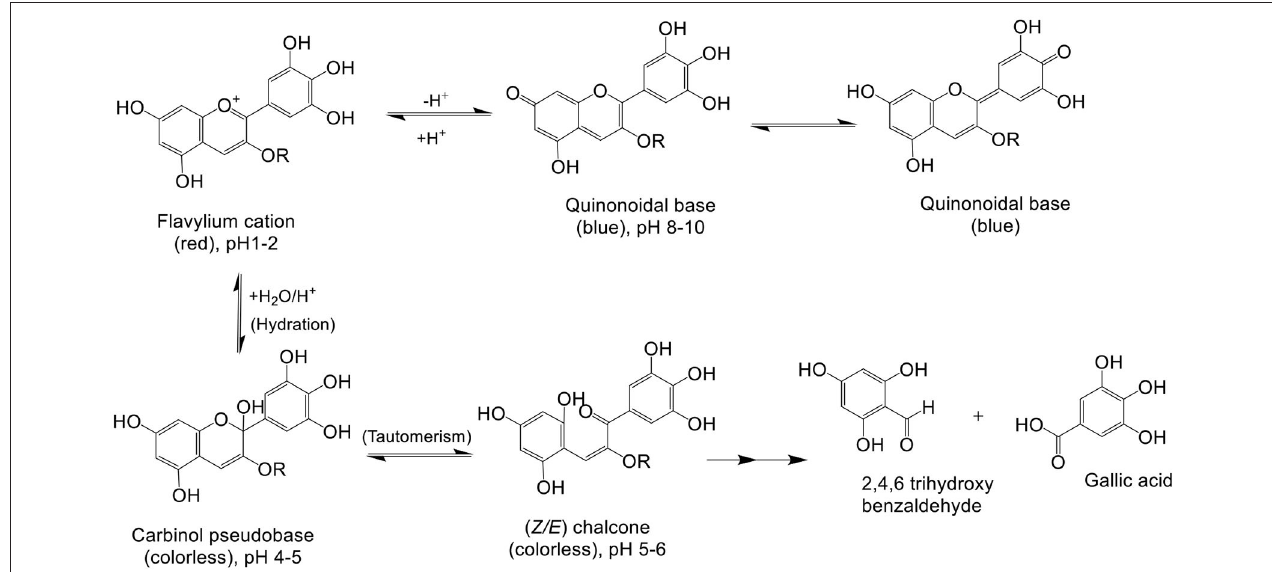
FIGURE 4 | pH-mediated degradation of delphinidin: in low pH, 1–2 red colored flavylium cations are observed, in alkaline pH 8–10 blue-color quinonoidal bases, in pH 4–6 colorless carbinol pseudobase and chalcone, and in pH > 7, degradation products of delphinidin, 2,4,6-trihydroxybenzaldehyde and gallic acid, are observed ( 45,